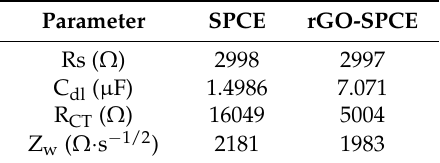
Table 1. Impedance circuit fitted parameters for SPCE and rGO-SPCE .